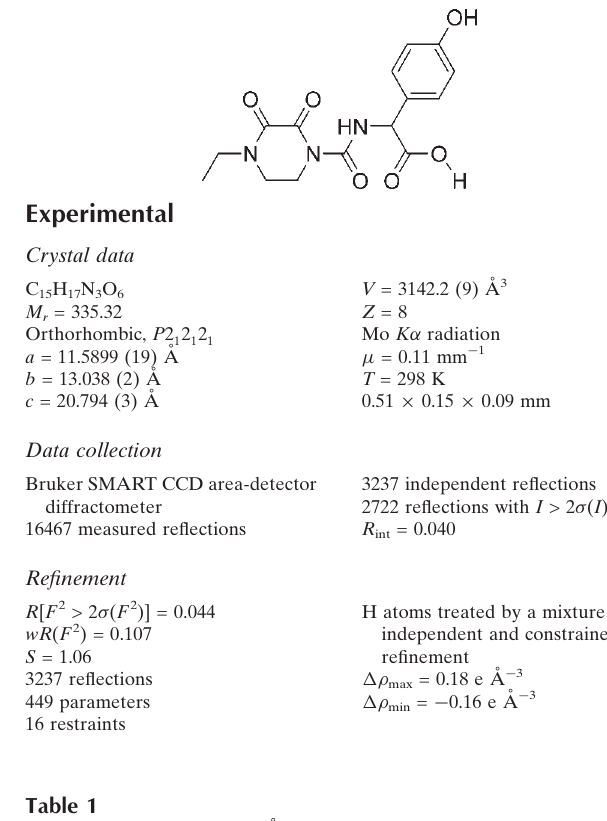
Hydrogen-bond geometry (A˚ , (cid:3)